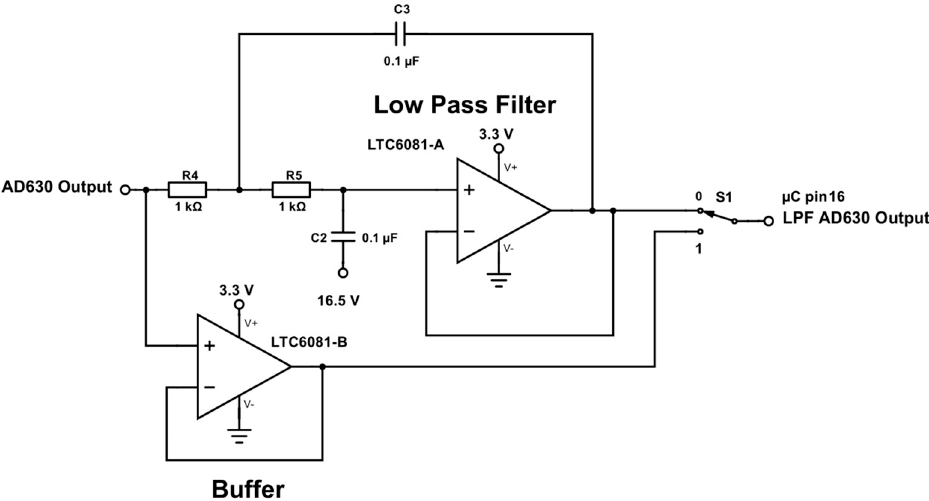
Figure 14. Circuit schematic showing the ADC buffering and low-pass filter stage of the AD630 output.